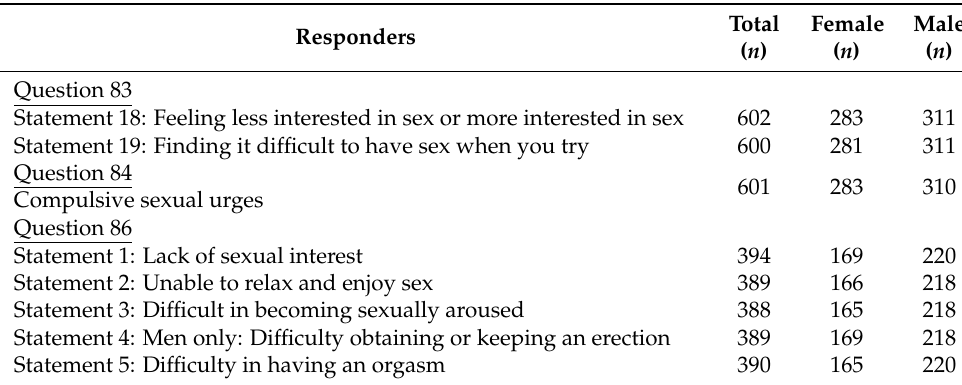
Table A1. Responding rates of the evaluated questions.